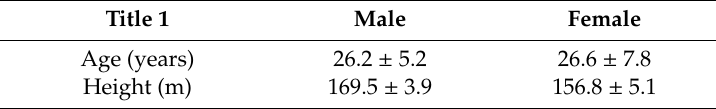
Table 1. Characteristics of the demographic data.